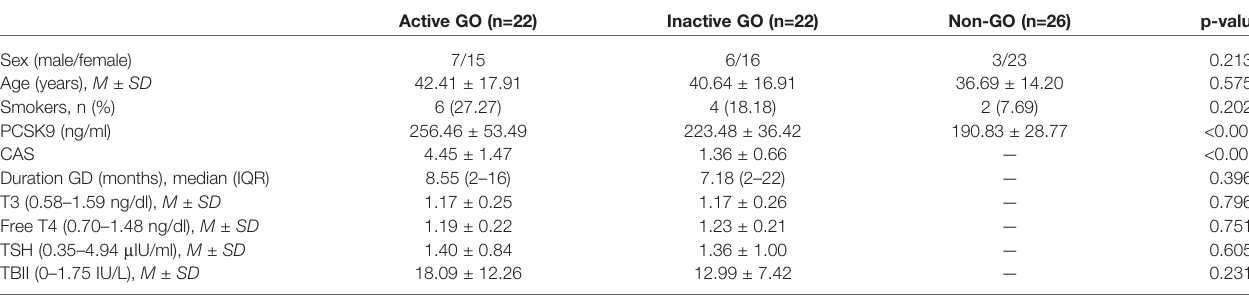
TABLE 1 | Clinical and serological characteristics of patient population for